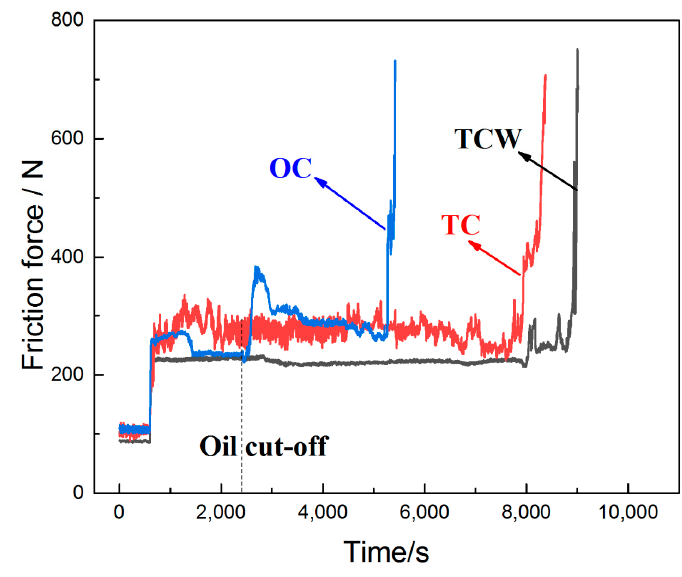
Figure 10. Scuffing time of samples during the anti-adhesion test.